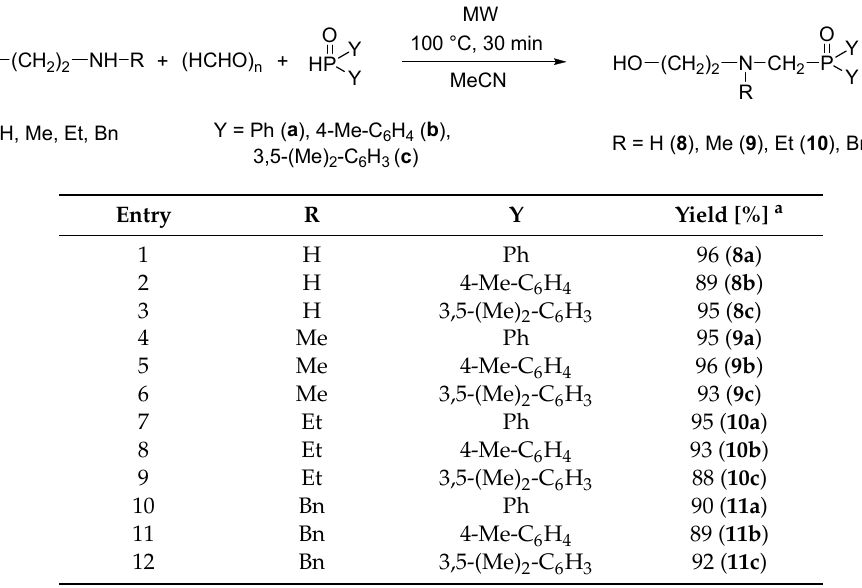
Table 4. Condensation of amino alcohols, paraformaldehyde, and secondary phosphine oxides.